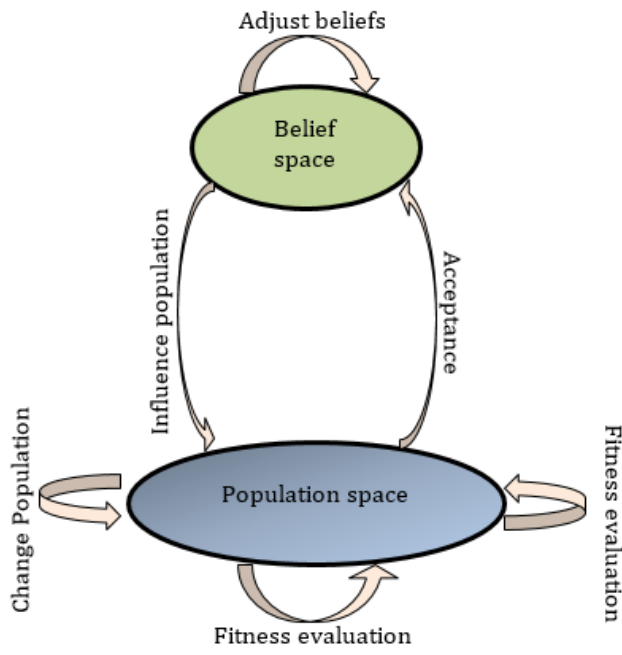
Fig 5 . Single objective CA